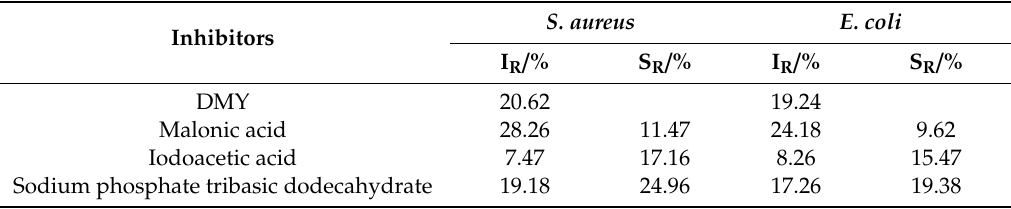
Table 2. The e ff ect of DMY on the respiratory metabolism of bacteria. Table 2. The effect of DMY on the respiratory metabolism of bacteria.